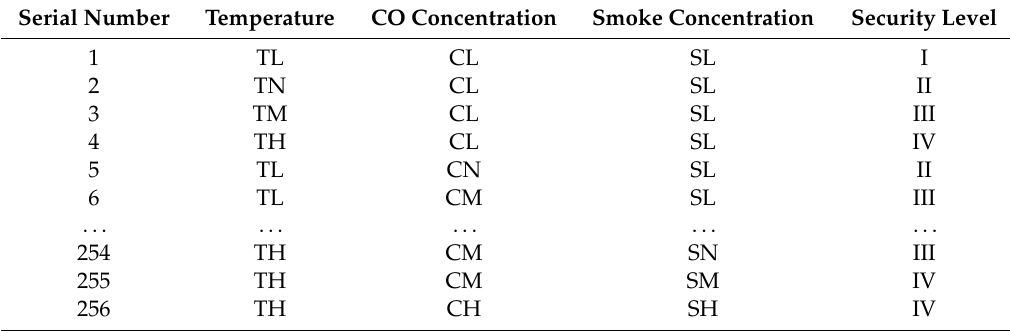
Table 2. Table of fuzzy